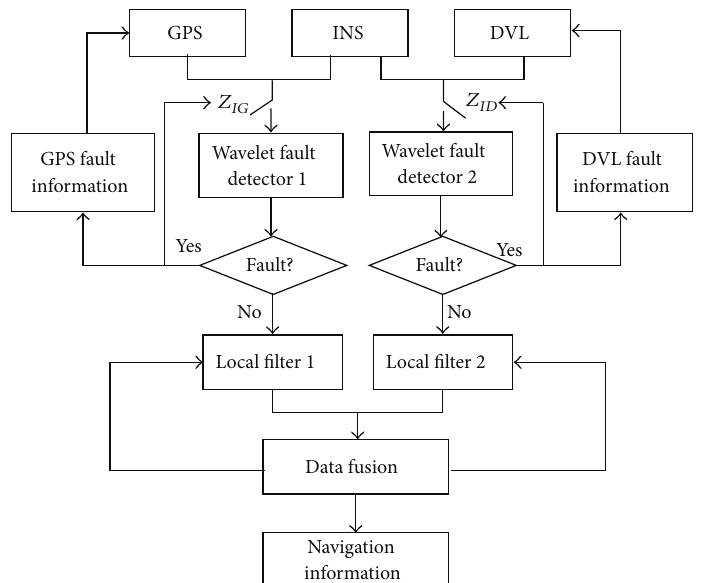
Figure 3: The fault-tolerant federated filter based on fault detection method for INS/GPS/DVL integrated navigation system.